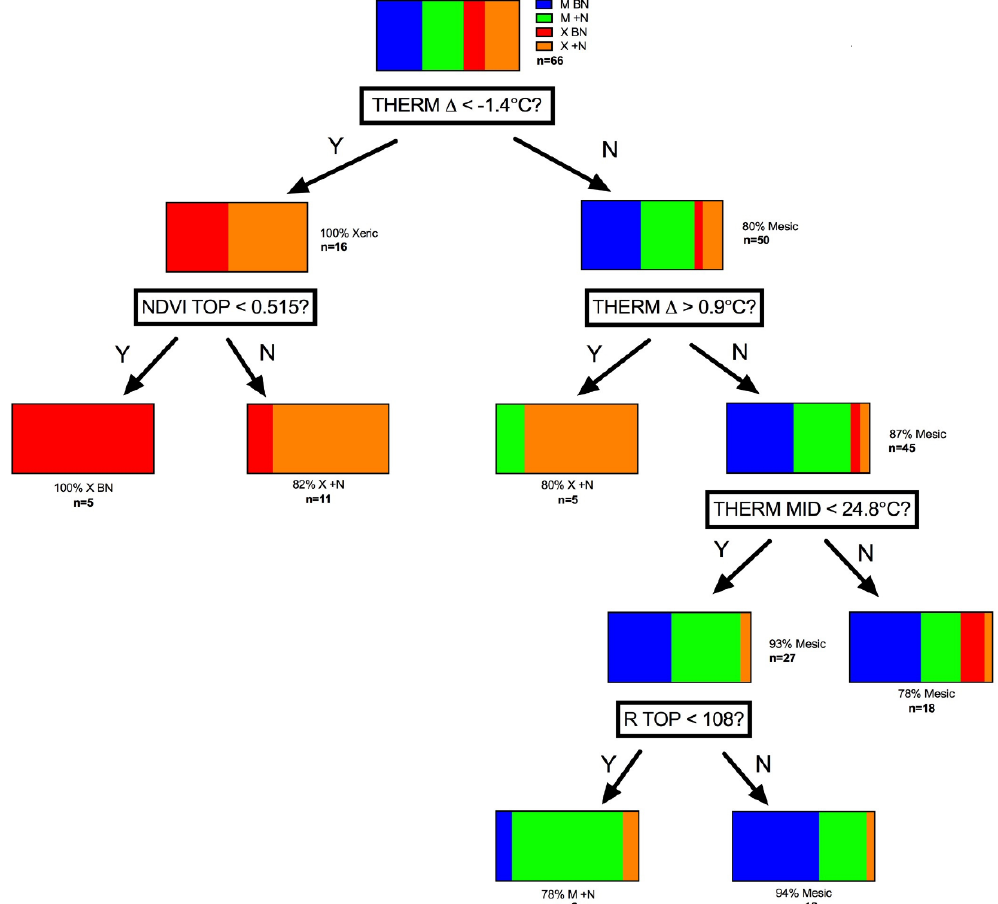
Figure 6. Classification tree model (CTM) for spectral traits within Jeffrey pine crowns. The difference in crown temperature between upper and mid crown (THERM Δ , upper crown cooler), separated trees in mesic and xeric microsites with 20% error. Further separation of xeric trees was accomplished with NDVI TOP also with 20% error. Further separation of mesic microsite trees into N level (BN or +N) was unresolved.